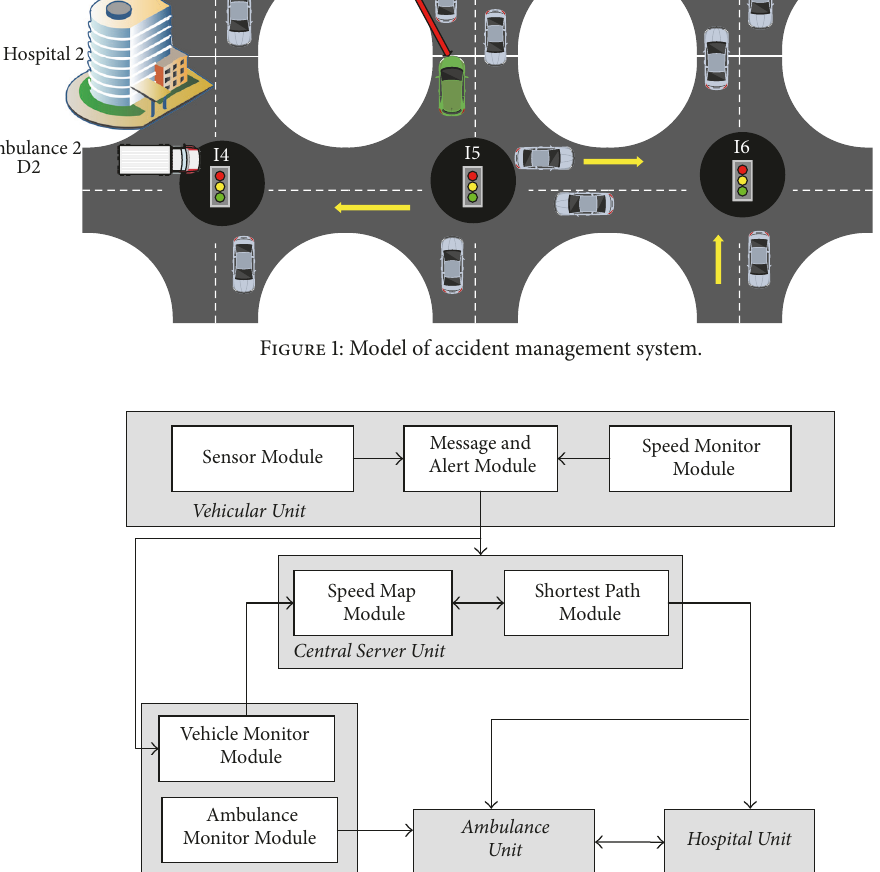
Figure 2: Architecture of accident management